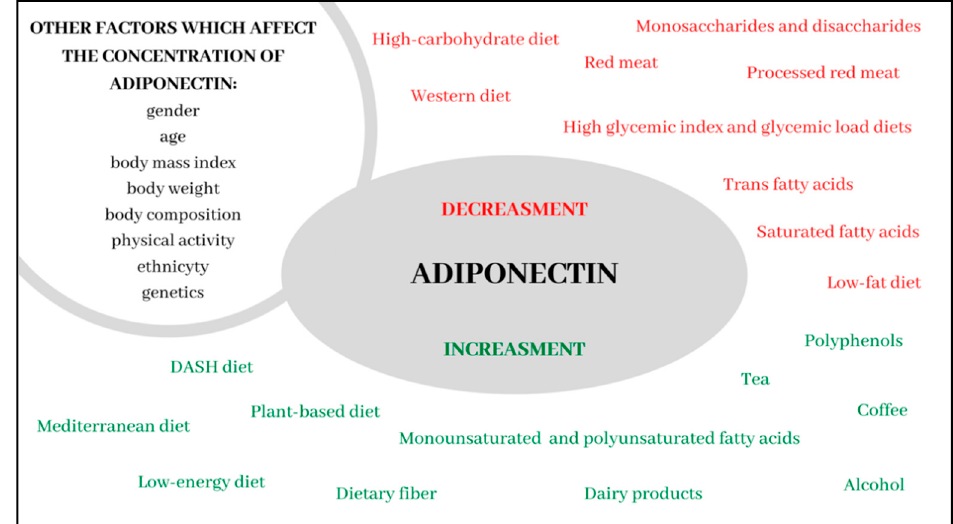
Figure 1. Summary of the influence of dietary factors on the concentration of adiponectin.